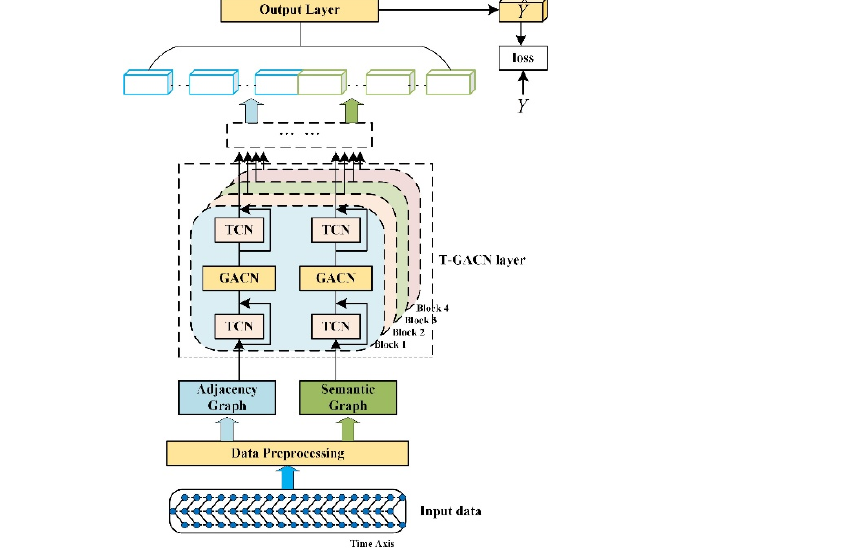
Figure 3. The framework of STSGAN. The input is χ ∈ R N × F × P , where N is the number of nodes, P is the time step length, and F is the feature of each node. The output is Y ∈ R N × Q , representing N node prediction speed in Q time steps. Four parallel T-GACN blocks form a T-GACN layer in the model, and three T-GACN layers are connected to extract high-dimensional features. Two of these layers parallel two graph attention blocks per layer. The graph attention convolutional network is sandwiched between two temporal causal convolutions.